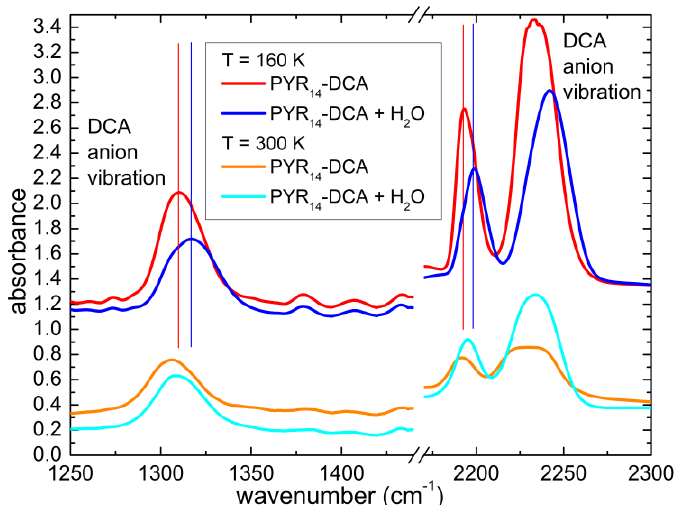
Figure 8. Comparison of the infrared absorption spectra measured at 160K and 300K of PYR 14 -DCA and PYR 14 -DCA+H 2 O in correspondence with three anion vibrational bands. The curves are vertically shifted for clarity.